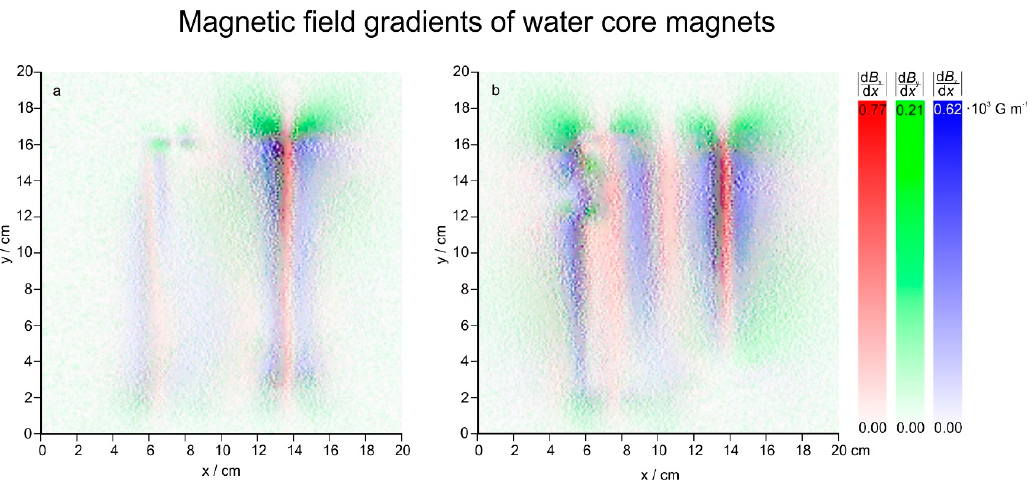
Figure 9. RGB composite magnetic field visualisations of WCMs 62083545 ( a , left) and 62081992 ( b , right). The image is 20 ˆ 20 cm 2 , every pixel is 1 mm. Figure 10 should be replaced by the following figure: